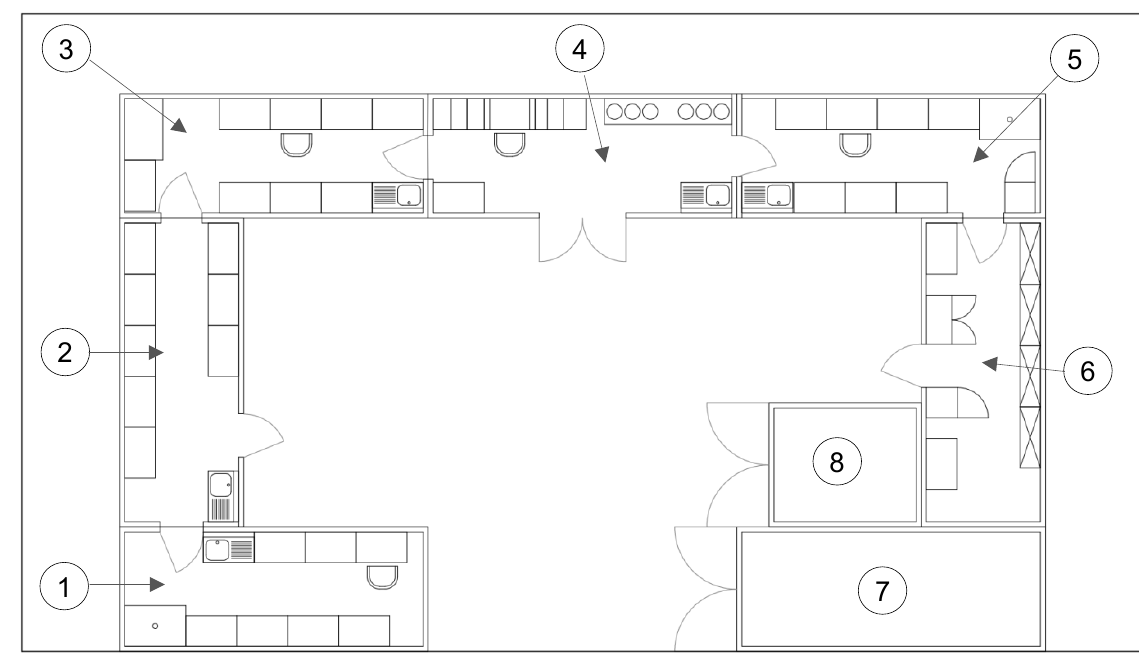
Figure 6 : floor plan of the lab container